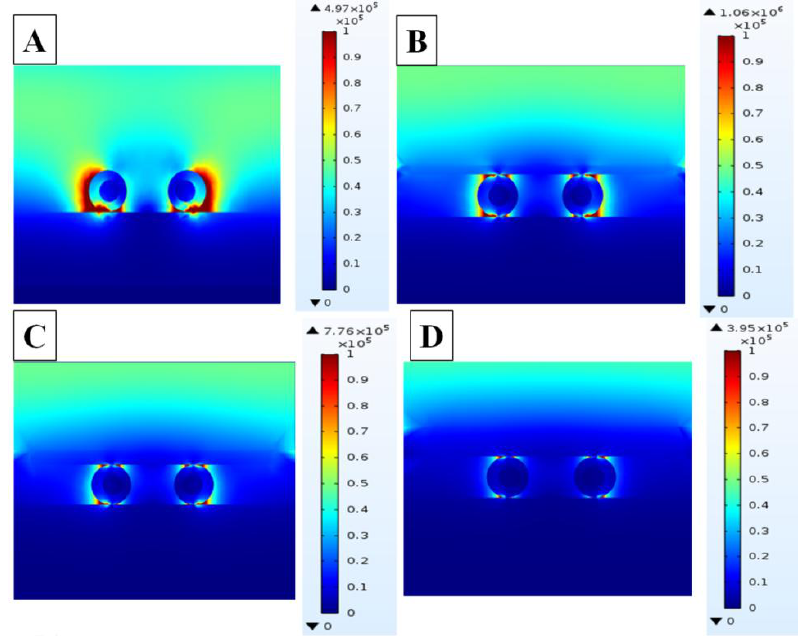
Figure 6. FDTD simulation of electromagnetic field distribution of sandwiched films under the radiation of 633 nm laser: ( A ) Ag mirror/Au nanorings and ( B – D ) Ag mirror/Au nanorings/Ag cover with different cover thicknesses of 9 nm, 15 nm, and 30 nm.